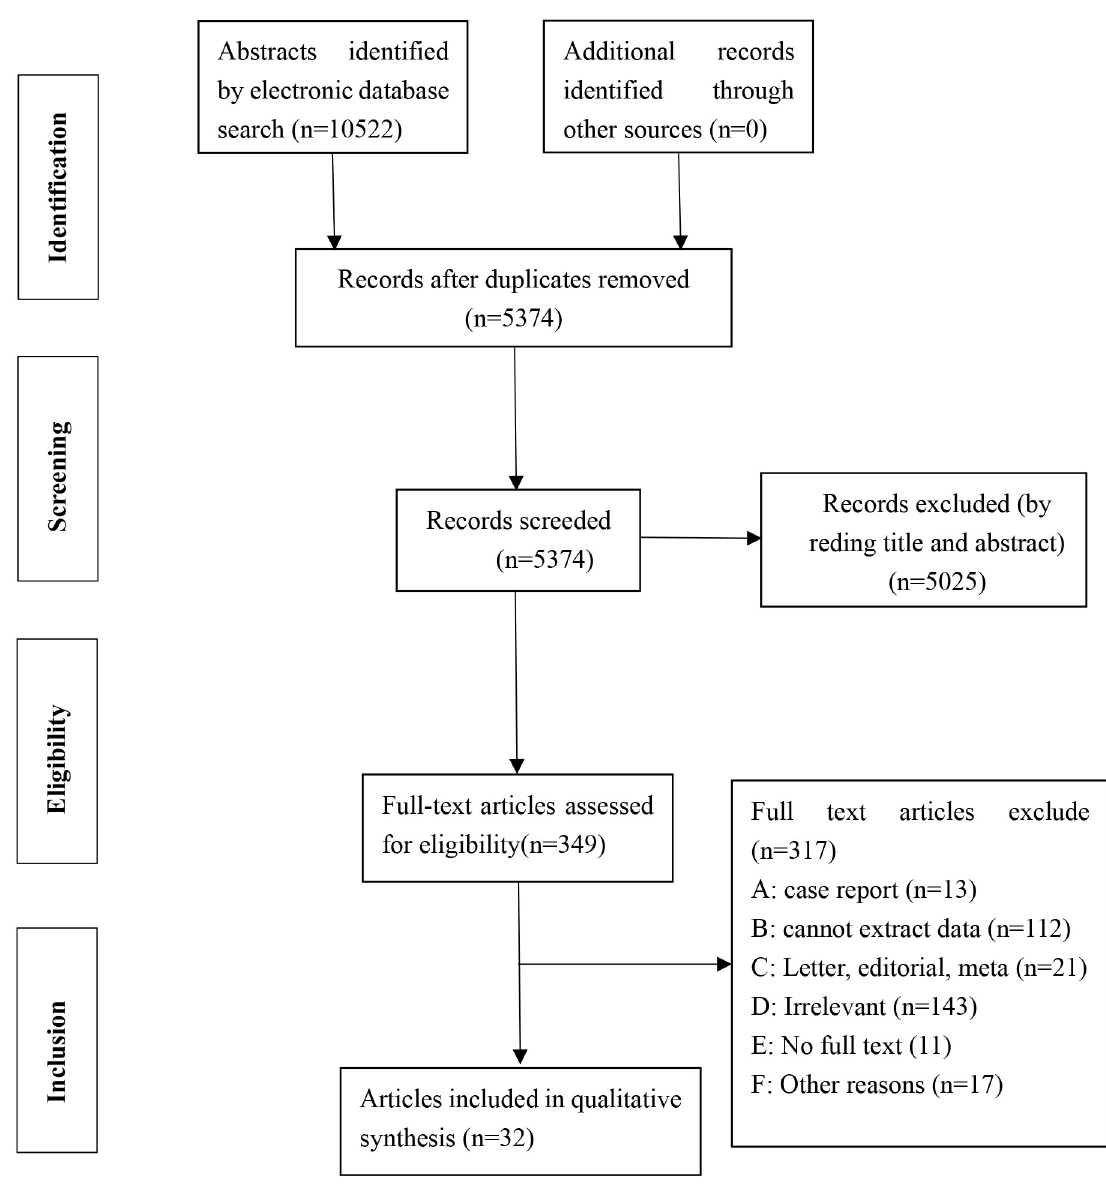
Fig 1. PRISMA flowchart used in the Study